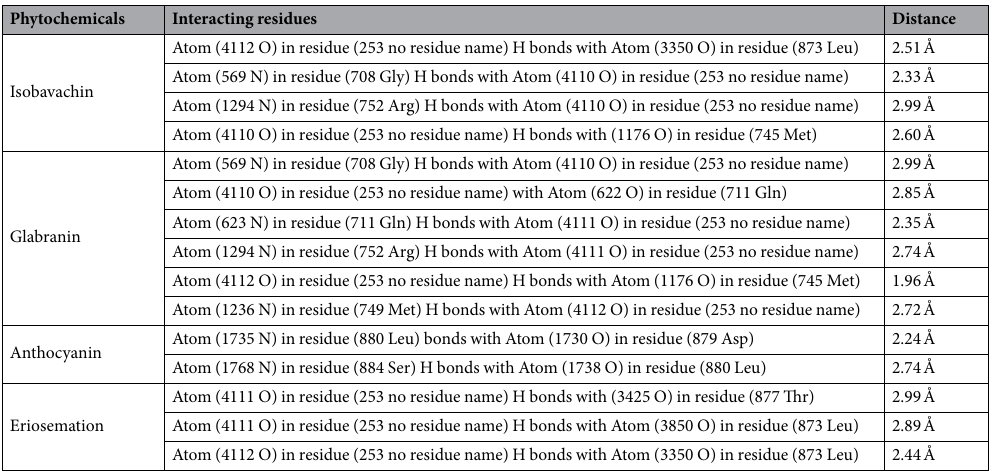
Table 5. Intermolecular H bonds between shortlisted phytochemicals with